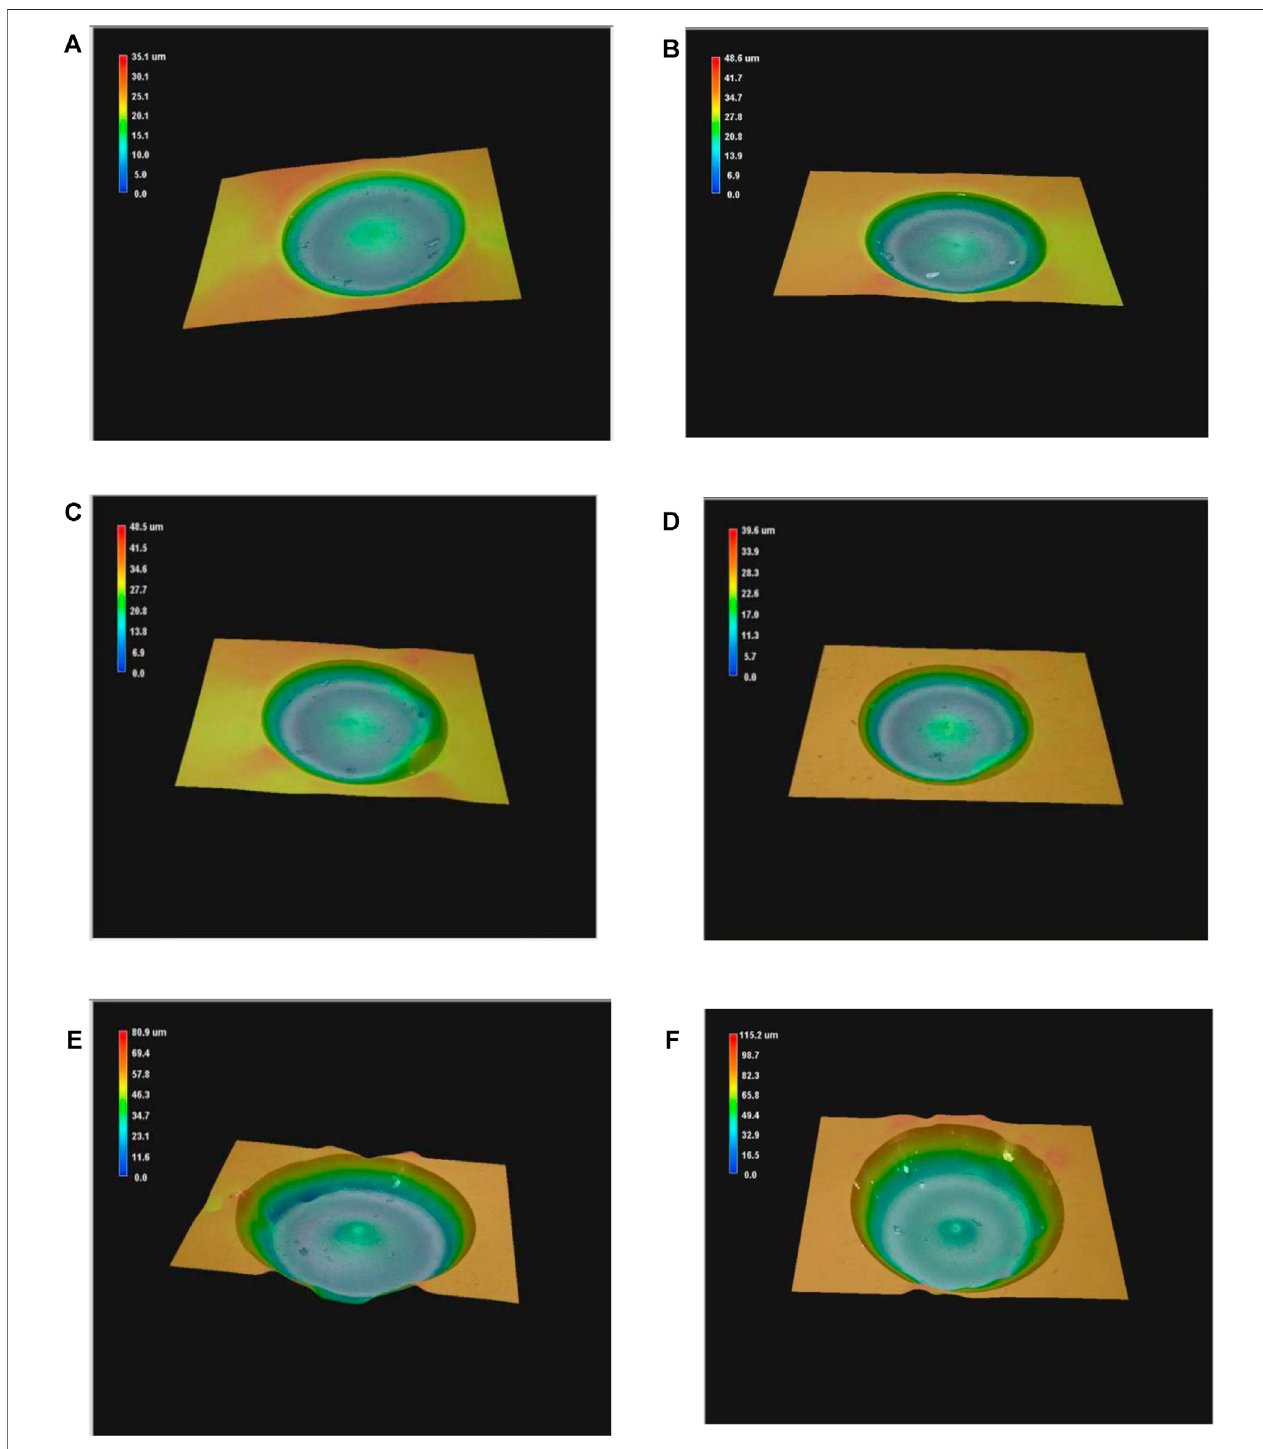
FIGURE12| Machiningperformanceofmicro-holesunderexperimentalconditions: (A) P =4 MPa; t =60 sandwithoutultrasonicvibration; (B) P =4 MPa; t =60 s and with ultrasonic vibration; (C) P = 6 MPa; t = 40 s and without ultrasonic vibration; (D) P = 6 MPa; t = 40 s and with ultrasonic vibration; (E) P = 8 MPa; t = 60 s and without ultrasonic vibration; (F) P = 8 MPa; t = 60 s and with ultrasonic vibration.